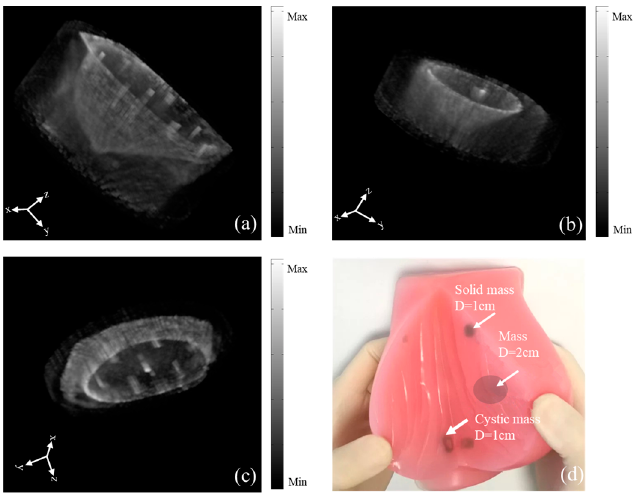
Figure 7. ( a ) Experimental setup. ( b ) PC workstation. ( c ) 64 channel ultrasonic signal receiving and transmitting circuits. ( d ) Diagram of the clinical imaging.